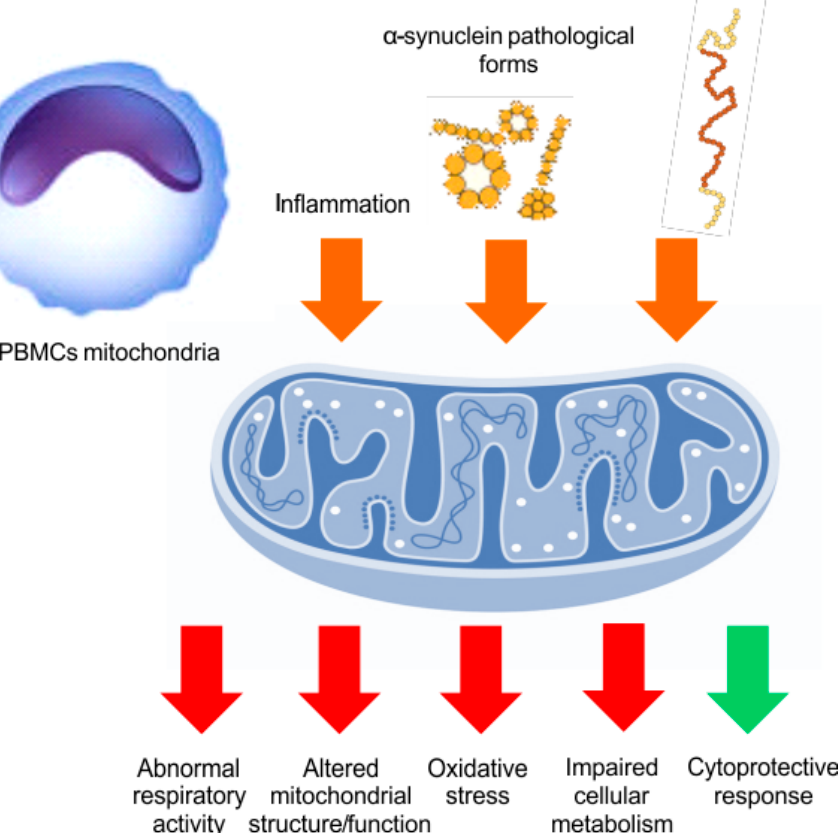
Figure 3. PBMCs mitochondrial function. In PD and HD, the systemic inflammation and the circu- lating neurodegeneration-related peptides (orange arrows) might affect the PBMCs mitochondrial function, inducing altered function or morphology, abnormal respiratory activity, increased oxidative stress, and impaired cellular metabolism (red arrows). However, some protective mechanisms could also be triggered (green arrow), especially at early disease stages, although they would be later overwhelmed by clinical-pathological